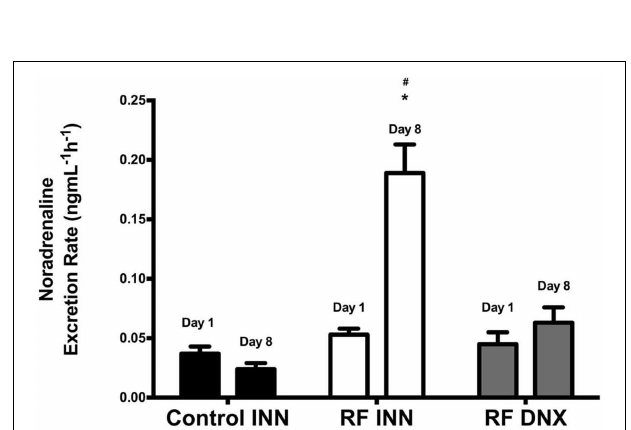
TABLE 2 | Baseline mean arterial pressure (MAP), heart rate (HR) and renal sympathetic nerve activity (RSNA) and baroreflex gain curve parameters. Control INN